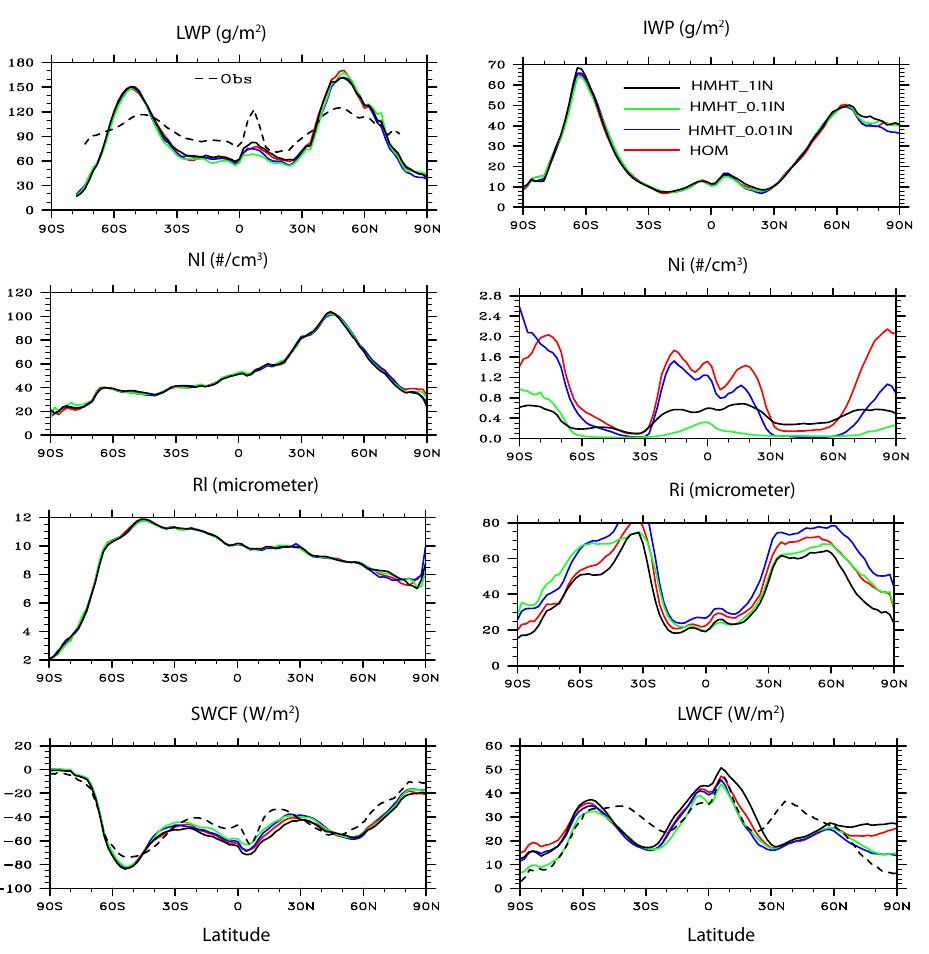
2 ), ice water path (IWP,g/m 2 ), cloud top in-cloud liquid droplet Figure 01 Fig. 1. Annual average zonal mean liquid water path over ocean (LWP, g/m number concentration ( N l , #/cm 3 ), cloud top liquid droplet effective radius ( R l ,µm), cirrus cloud top in-cloud ice crystal number ( N i , #/cm 3 ), and cirrus cloud top ice crystal radius ( R i , µm), shortwave cloud forcing (SWCF, W/m 2 ), and longwave cloud forcing (LWCF,W/m 2 )